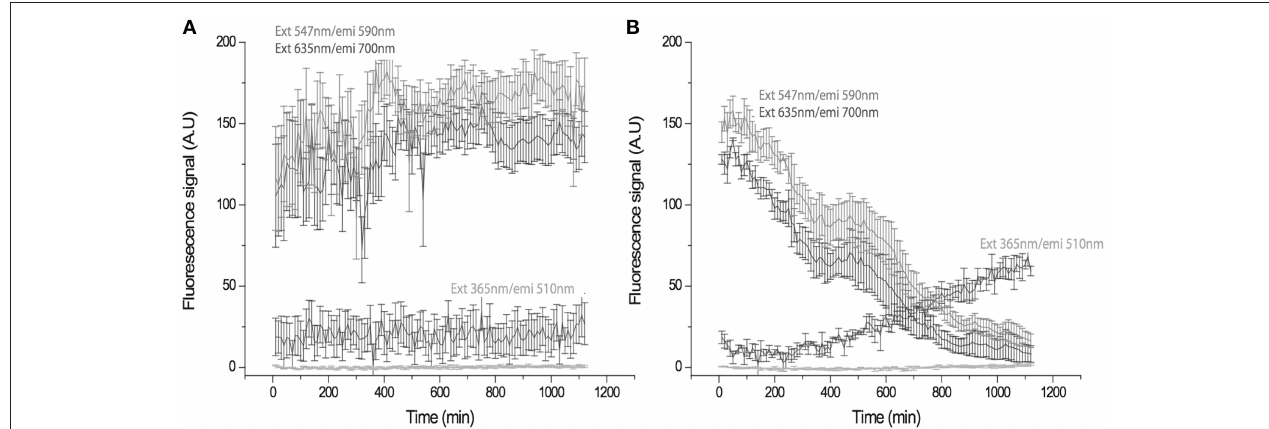
FIGURE 4 | Time-trace showing fluorescence signal in arbitrary units (A.U.) of the cells at different emission longitudes in the absence (A) and presence of U (B) . (A) The control emission remains constant, cells emitted at 590 and 700nm, after 20h. (B) The U-exposed sample shows a gradual change in the emission of the cells from 590nm and 700nm to 510nm. Changes are compatible with U uptake being appreciable at 10h. Maximum intensity is reached at 20h. (ext, excitation; emi,